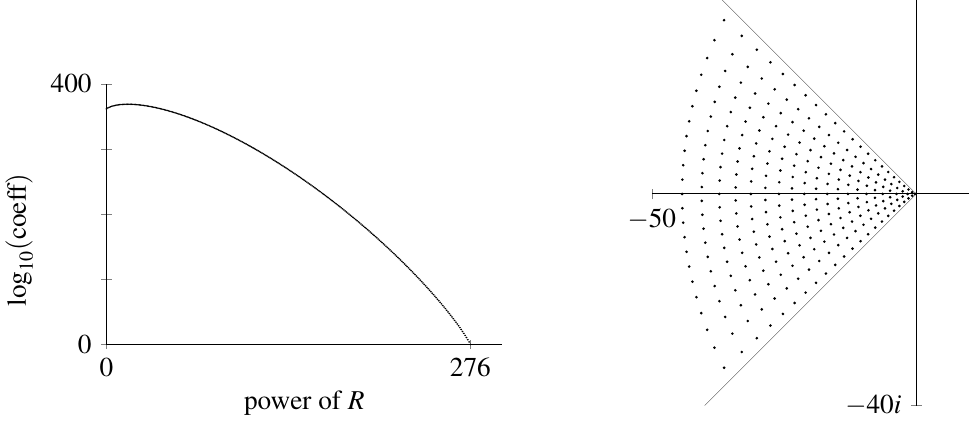
Figure 1: On the left is a graph of the base-10 logarithm of the coefficients of the polynomial N 22 ( R ) , which is the numerator of the magnitude of the 45-dimensional ball; this clearly illustrates the log- concavity. On the right is a plot in the Argand plane of the complex roots of N 22 ( R ) ; these all lie between the pictured rays { z | arg ( z ) = 3 π / 4 } and { z | arg ( z ) = 5 π / 4 } . Both sets of data were computed numerically with